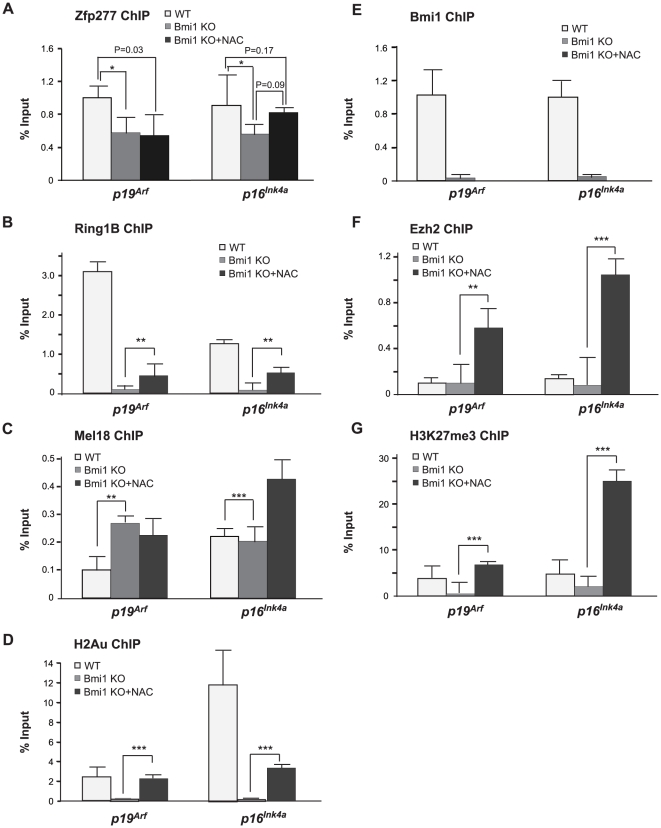

Bmi1-deficiency does not greatly affect the binding of Zfp277 to the Ink4a/Arf locus in early passage presenescent cells.
A–G. The ChIP analysis of the p19Arf exon 1b and p16Ink4a exon 1a in Bmi1
−/− MEFs. Wild-type and Bmi1
−/− MEFs (P-2) pretreated with 10 mM NAC were subjected to ChIP analyses using the indicated antibodies. Percentages of input DNA are shown as the mean ± S.D. for multiple experiments (n>5). Statistical significance was determined with Student's t-test; *p<0.05, **p<0.01, ***p<0.001.